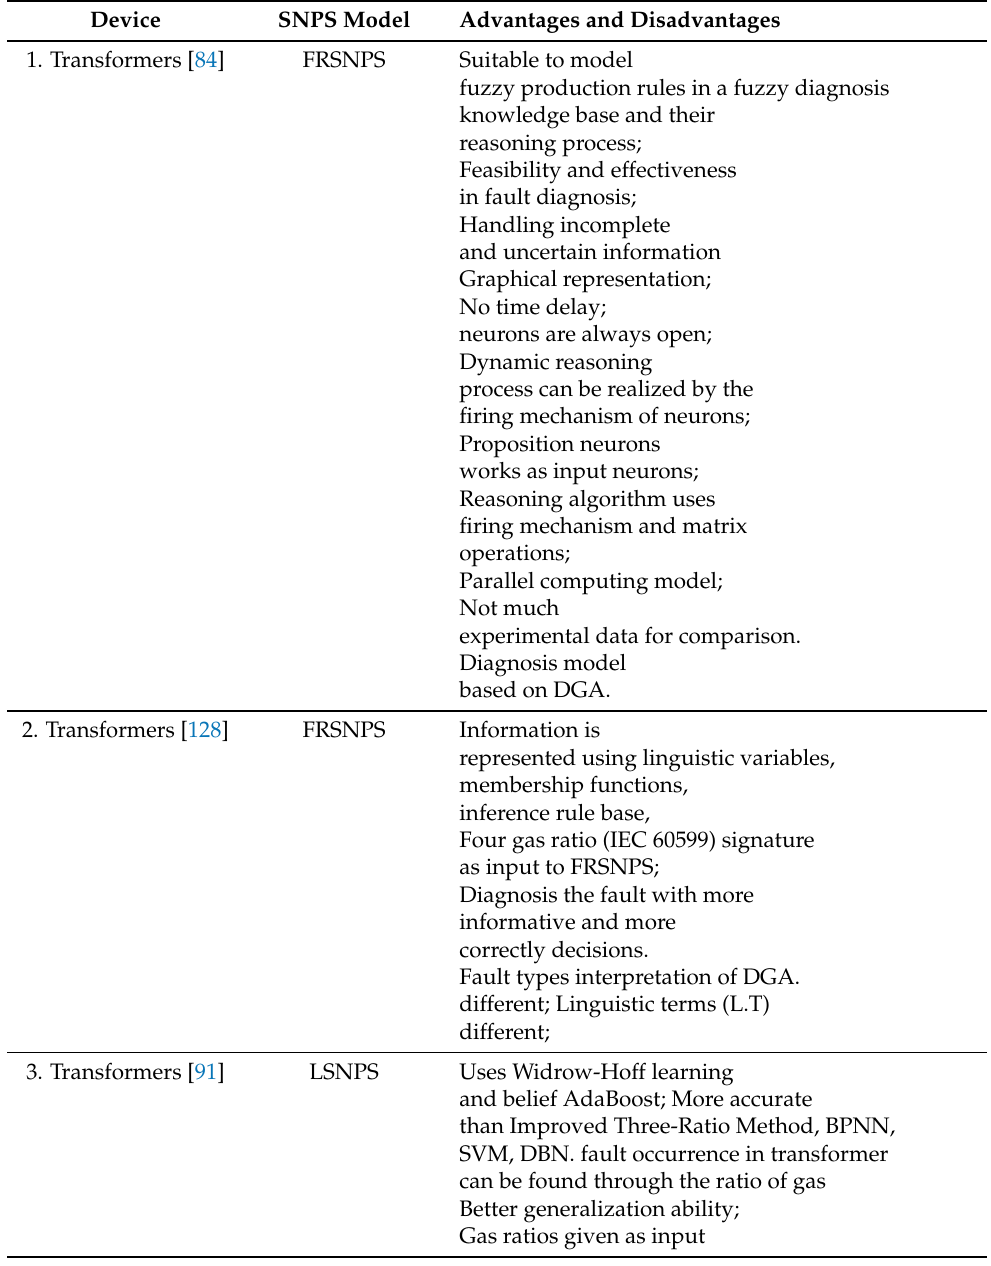
Table 3. Advantages and disadvantages of fault diagnosis models for transformers with spiking neural P